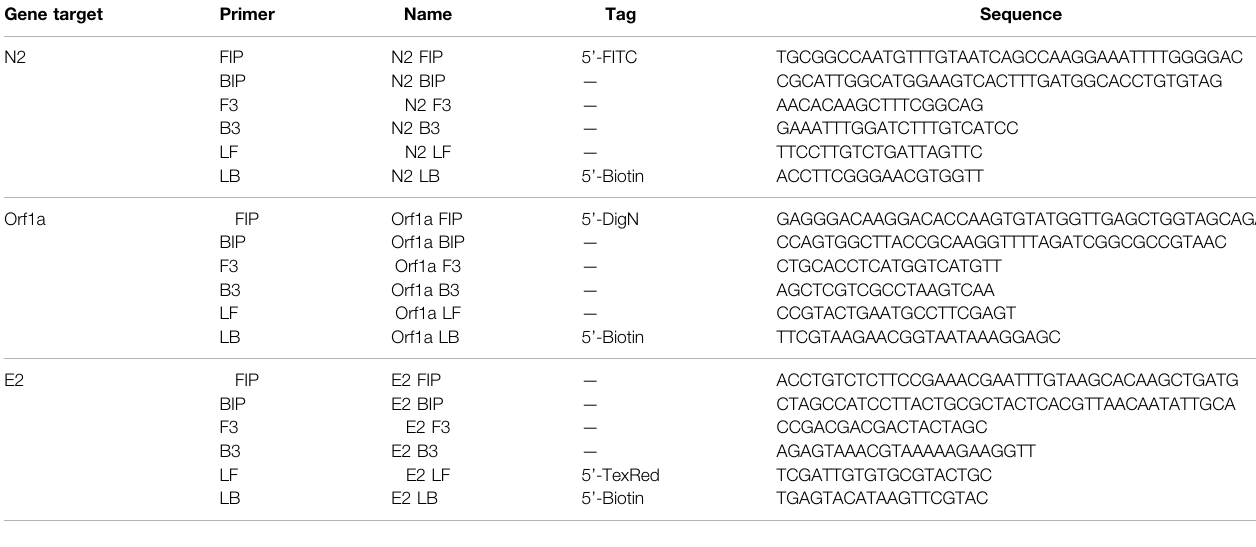
TABLE 3 | Primer sequences against Nucleocapsid (N-2), Envelope (E-2), and Orf1a-1 genes of the SARS-CoV-2 virus.